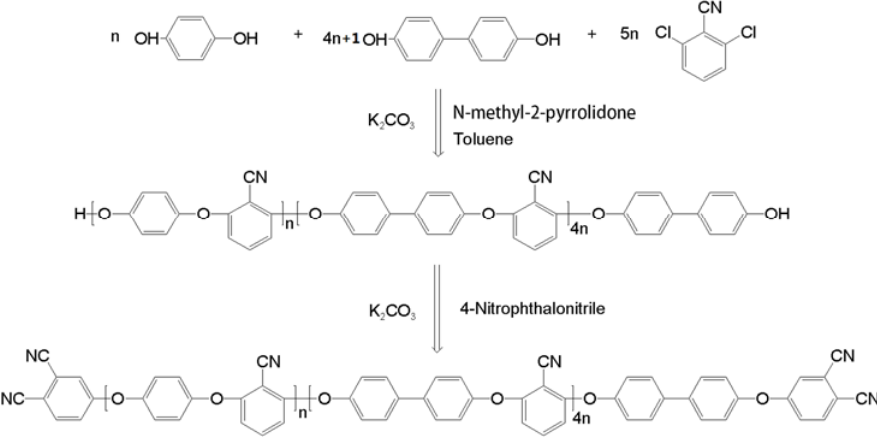
Figure 1. Synthetic route of phthalonitrile ‐ terminated polyaryl ether nitrile (PEN ‐ Ph).